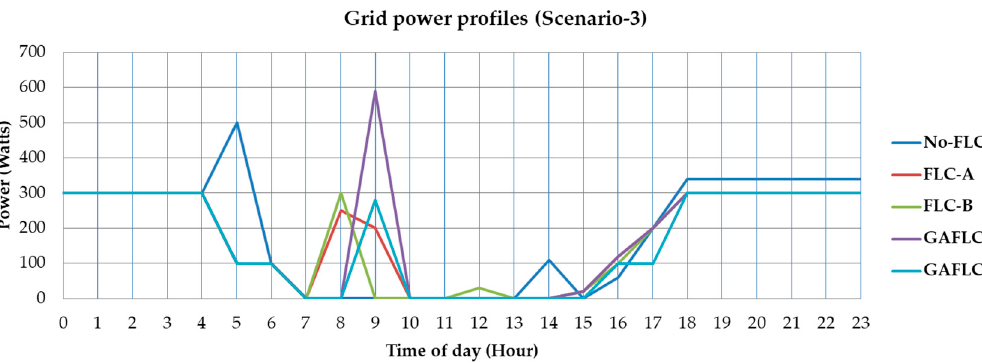
Figure 14. The grid power profiles in Scenario 2 (No-FLC, FLC-A, FLC-B, GAFLC-A, GAFLC-B).